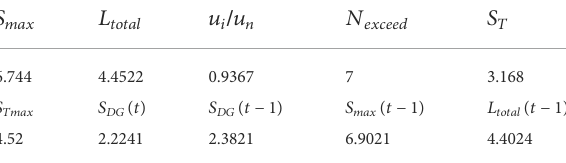
TABLE 3 Simulation results of operation parameters of the ADN under scenario